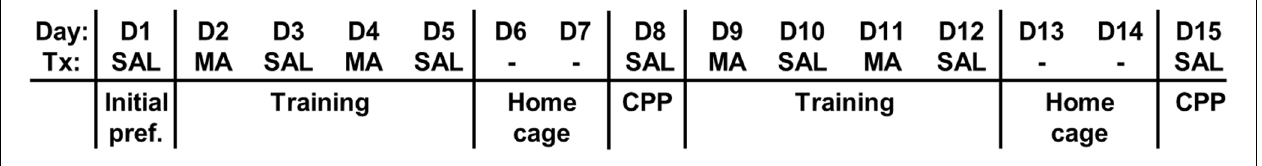
FIGURE 1 | Schematic of the MA-CPP protocol. We used a 15-day protocol whereby mice were assessed for initial preference for the drug-paired side (D1, initial preference), trained for two separate 4-day sessions with alternating injections of MA and SAL in the respective contexts (D2–D5;